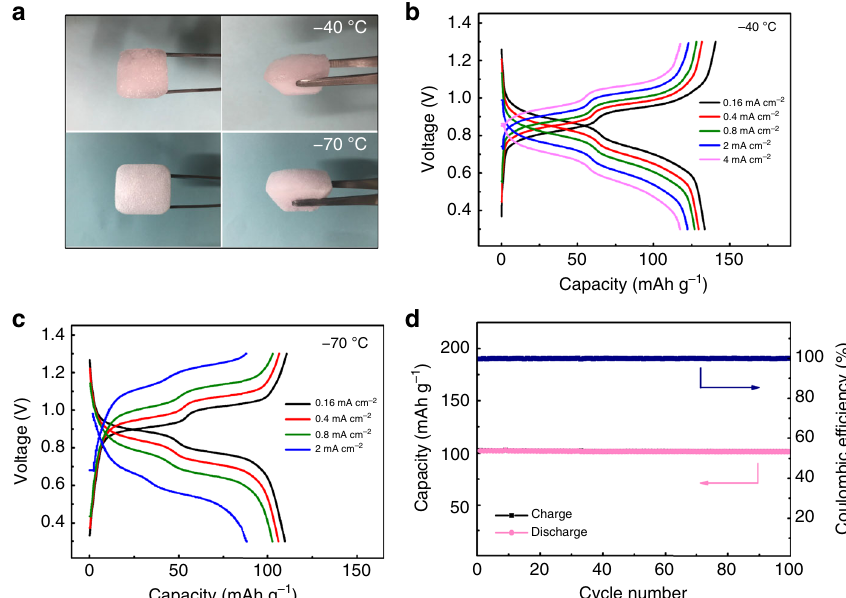
Fig. 5 Low-temperature behavior investigations of the PTO//MnO 2 @GF hydronium-ion battery. a Optical photographs of the hybrid electrolyte (2 M MnSO 4 + 2 M H 2 SO 4 ) after remaining at − 40 °C (above) and − 70 °C (below) for several hours. b , c Rate ability of the PTO // MnO 2 @GF hydronium-ion battery described by galvanostatic charge-discharge pro fi les at various current densities at − 40 °C ( b ) and at − 70 °C ( c ). d Cycle performance at − 70 °C of the hydronium-ion battery tested at a current density of 0.8 mA cm − 2 (1